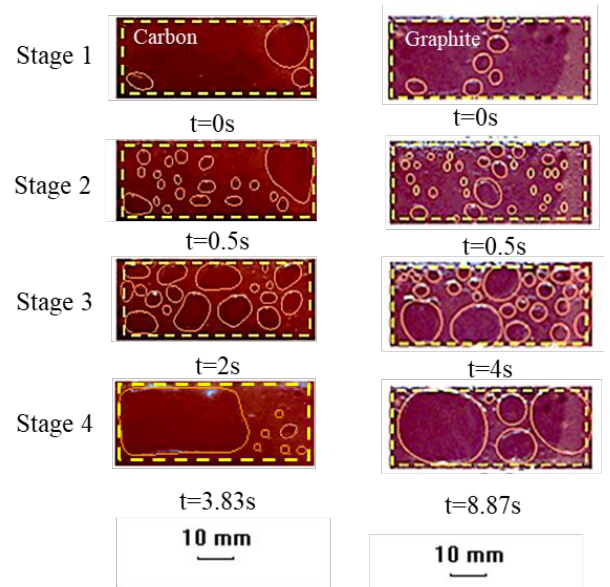
Figure 5. Comparison of bubble behavior between carbon and graphite anodes at a current density of 0.7 A·cm ‒2 . Stage 1: Just after bubble release; Stage 2: Bubble growth; Stage 3: Bubble growth and coalescence; stage 4: Just before bubble release.